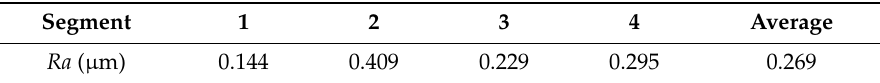
Table 5. Roughness Ra in the different segments of the milled cam.